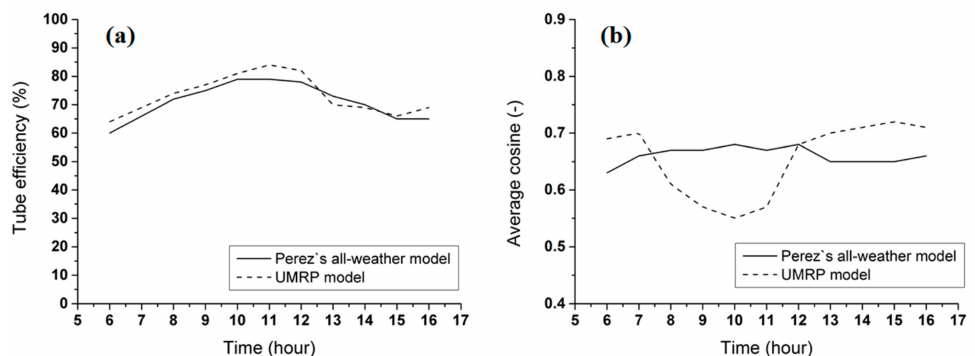
Figure 10. The same as in Figure 6, but for a partly cloudy day, 14 June 2015.